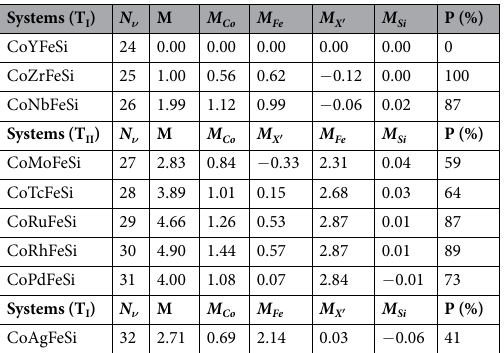
Table 4. Total and atomic magnetic moments in μ B / f . u . and the calculated spin polarization P of CoX ′ FeSi systems. N ν is the number of valence electrons of the systems. M is the total